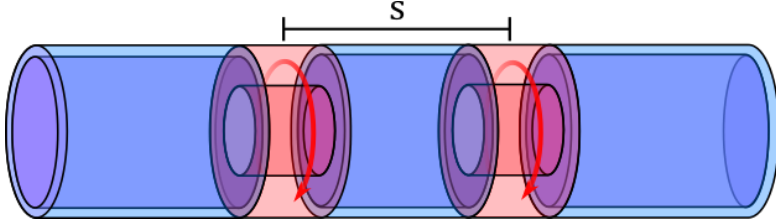
Figure 1. The concept of the Polymer Optical Fiber (POF) sensor. Annular cavities are milled in the fiber at specific locations. These cavities are then filled with a gel solution of PMMA and solvent, containing photoluminescent molecules quenchable by oxygen. The solvent evaporates and leaves a PMMA matrix with embedded photoluminescent